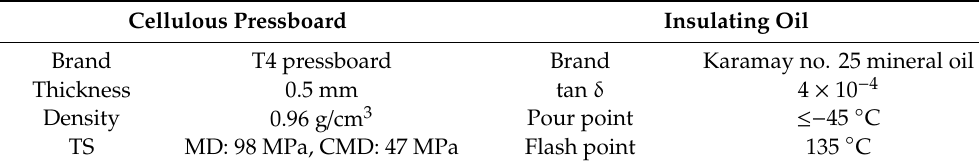
Table 1. Details of the cellulose pressboards and mineral insulating